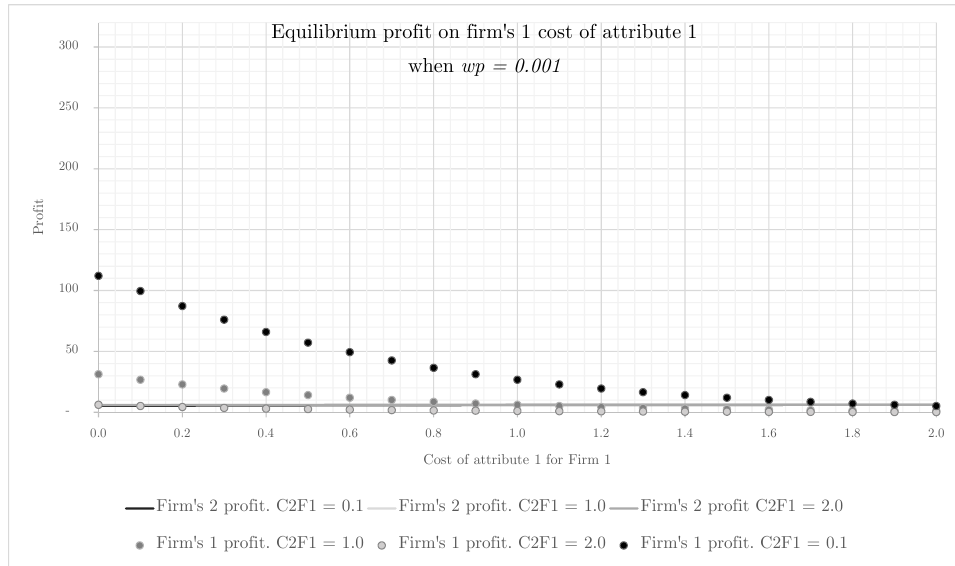
Figure A7. Firms’ profit share varying attributes’ cost of Firm 1 when wp ≈